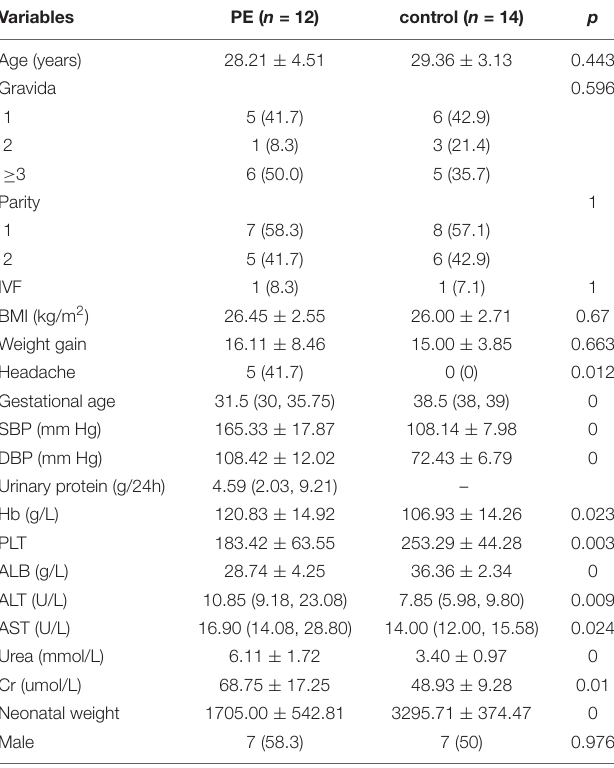
TABLE 1 | The characteristics of the preeclampsia and normotensive pregnant